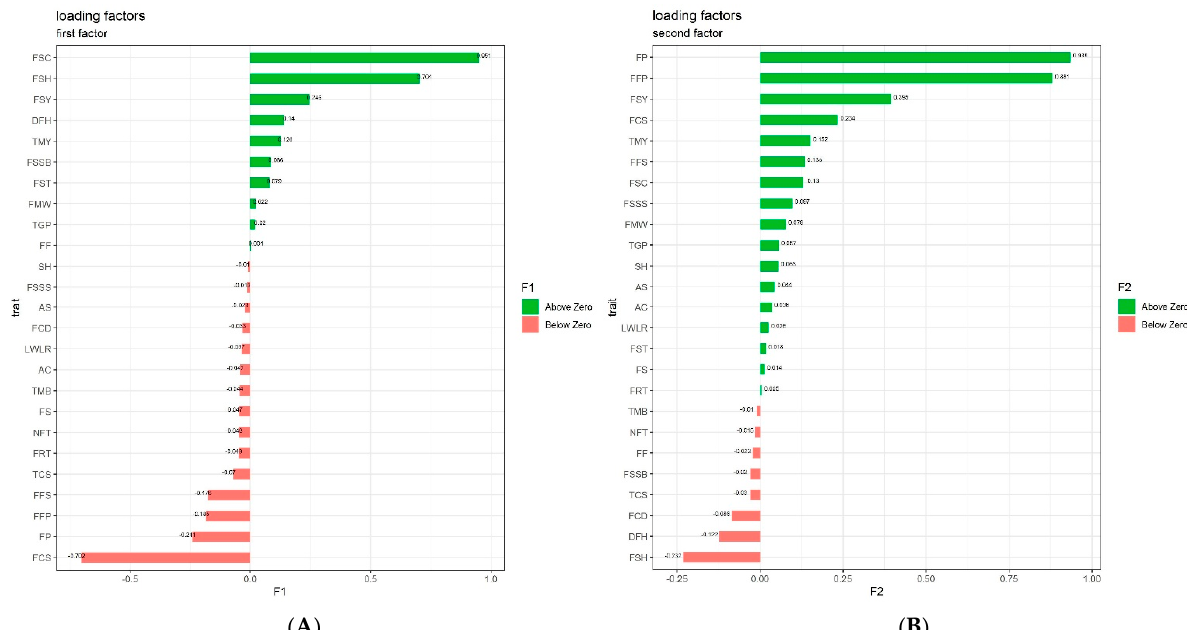
Figure 3. Eigenvectors for the variables of the first ( A ) and second ( B ) factors. Tree Crown Shape ( TCS ); Tree Growth Power ( TGP ); Thorn in Mature wood Branch ( TMB ); Length − to − width Leaf Ratio ( LWLR ); Flower Position ( FP ); Flower Formation Site ( FFS ); Dominant Flowering Habit ( DFH ); Fruitful Flowers Percentage ( FFP ); Flower Cup Diameter ( FCD ). Fruit Size ( FS ); Fruit Skin thickness ( FST ); Fruity Skin Sensitivity to Burst ( FSSB ); Fruit Skin Sensitivity to Sunburn ( FSSS ); Fruit Flavor ( FF ); Fruit Ripening Time ( FRT ); Fruit Skin Color ( FSC ); Fruit Shape ( FSH ); Fruit Crown Shape ( FCS ); Fruit symmetry ( FSY ); Aril Size ( AS ); Seed Color ( SC ); Seed Hardness ( SH ); Number of fruits in tree ( NFT ); Fruit mean weight (g) ( FMW ); Tree mean yield ( TMY ). A two-dimensional scatter plot was drawn based on the first and second factors, and genotypes were grouped from 1 to 10 groups (Figure 4).